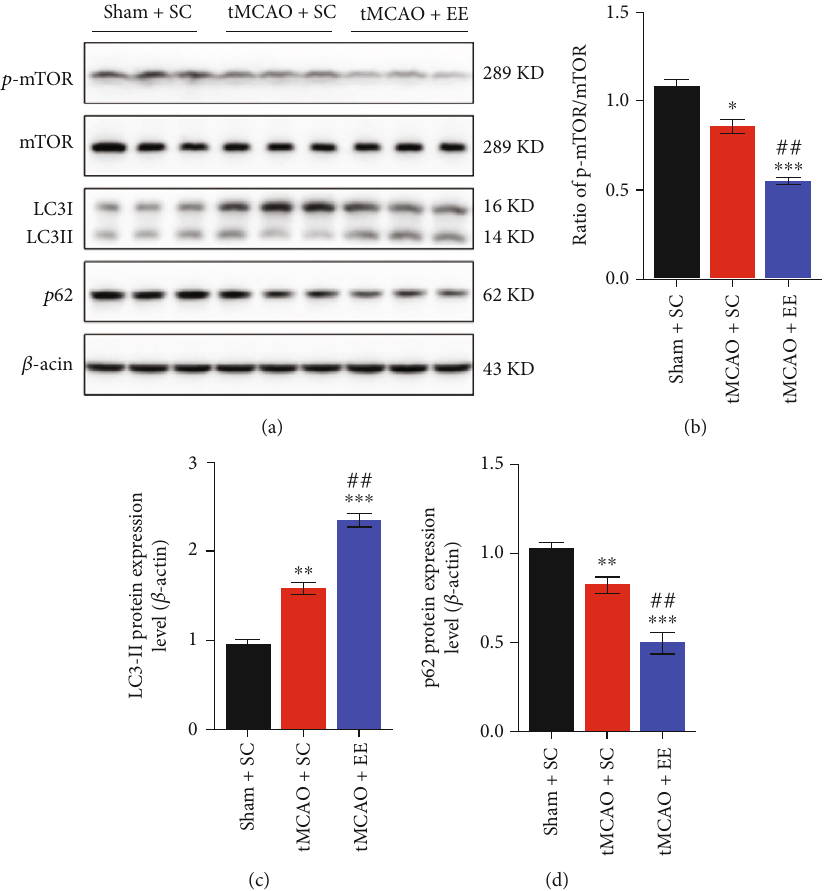
Figure 5: (a) Representative Western blot images for autophagy. (b) Comparison of the p-mTOR/mTOR ratio between groups. (c) Comparison of the β -actin-normalized LC3-II protein level between groups. (d) Comparison of the β -actin-normalized p62 protein level between groups. ∗ P < 0 : 05 , ∗∗ P < 0 : 01 , and ∗∗∗ P < 0 : 001 vs . sham+SC group; ## P < 0 : 01 vs . tMCAO+SC